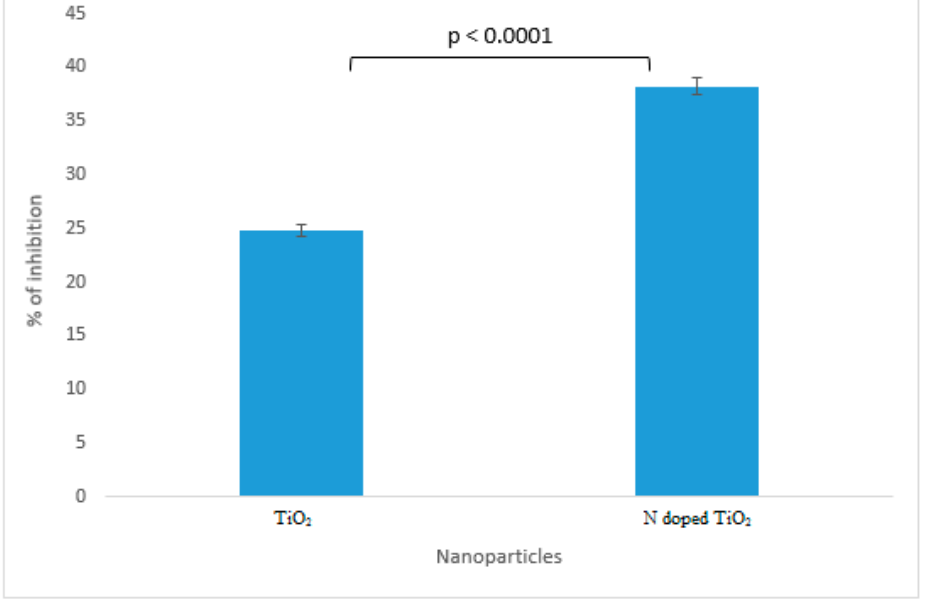
Figure 11. Antidiabetic activity exhibited by TiO 2 nanoparticles and N-doped TiO 2 nanoparticles against alpha amylase. Error bars are shown as standard deviation on each bar. Bars are significantly different at confidence interval level of 95%. Molecules 2019 , 24 , x